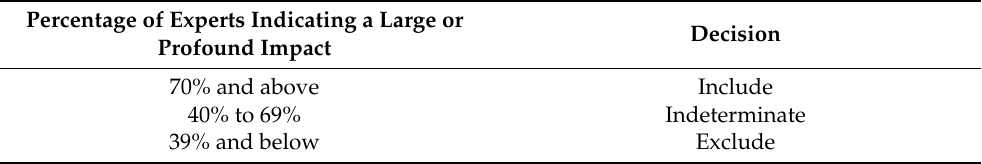
Table 4. Guidelines governing inclusion of indicators in the smart health